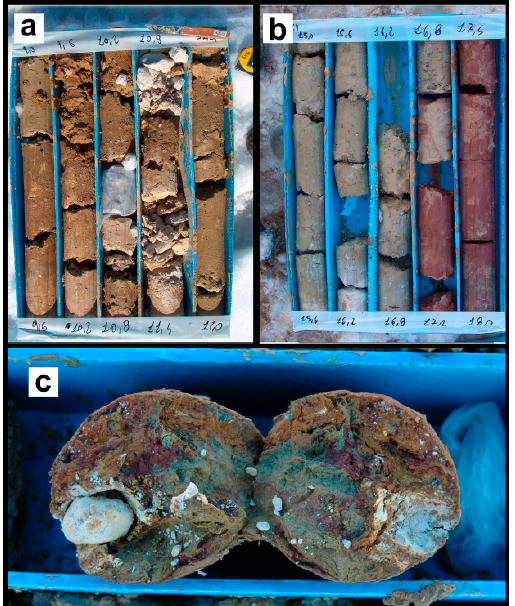
Figure 6. Photos of an exploration located near to the longitudinal axis of the sliding surface. ( a ) This photo represents the shallow part of the borehole, showing clays of several colors and dispersed red blocks in their matrix. ( b ) The photo shows the part of the borehole between 15 and 18 meters deep. ( c ) Fragment of limestone surrounded by a calcite coating. See the combination of red and green colors that can observed within the clays.